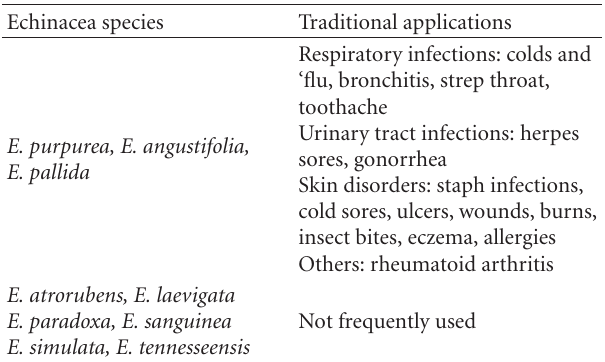
Table 1: Traditional uses of Echinacea (Coneflower) extracts. Echinacea